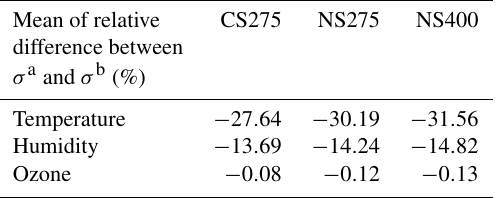
Table 4. Mean of relative differences between analysis-error stan- dard deviations and background-error standard deviations over 6123 profiles for temperature, humidity and ozone for the 3 channel se- lections. Mean of relative CS275 NS275 NS400 difference between σ a and σ b (%) Temperature − 27 . 64 − 30 . 19 − 31 . 56 Humidity − 13 . 69 − 14 . 24 − 14 . 82 Ozone − 0 . 08 − 0 . 12 − 0 .